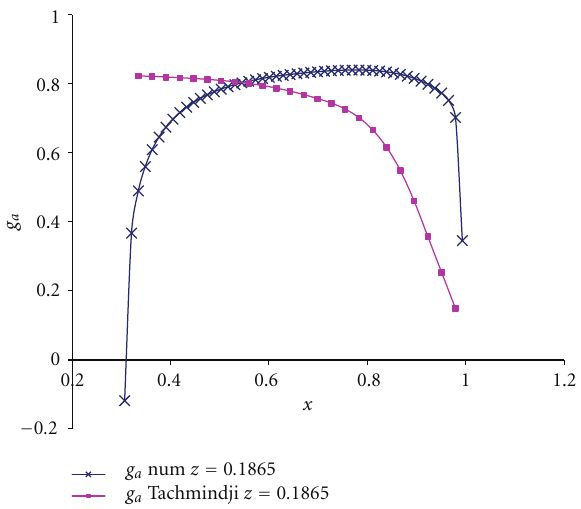
Figure 8: Interference factor predicted with numerical lifting line model and the analytical model by Tachmindji.